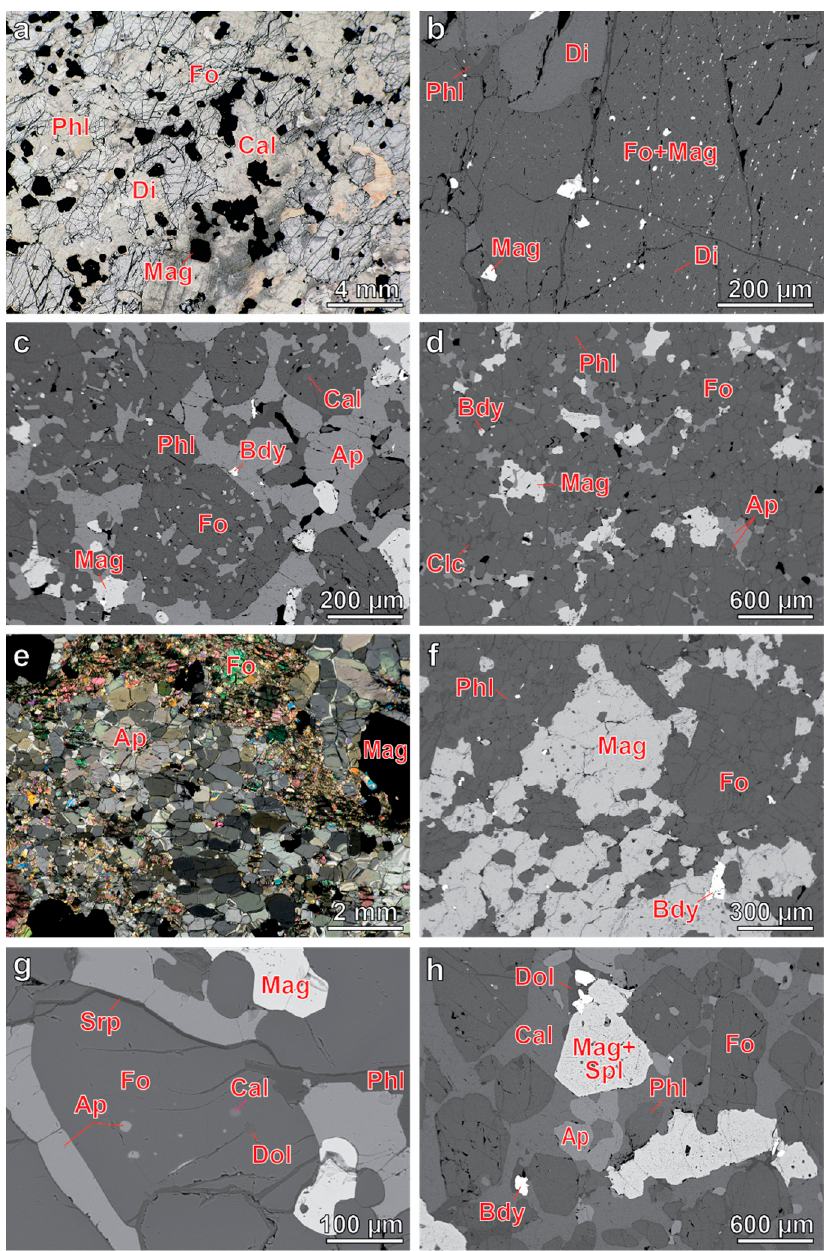
Figure 3. Morphology of forsterite and its relations with other minerals in rocks of the Kovdor alkaline-ultrabasic massif: ( a ) replacement of forsterite with diopside and phlogopite in peridotite 10p/76.01; ( b ) grain of forsterite with inclusions of diopside and magnetite in peridotite 912/231.6; ( c ) co-crystallization of forsterite (with inclusions of calcite) and hydroxylapatite in AF phoscorite 934/112.1; ( d ) interstitial segregations of magnetite and hydroxylapatite in AF phoscorite 976/33.1; ( e ) network of forsterite grains in MAF phoscorite 932/205.9; ( f ) typical MF phoscorite 983/64.6; ( g ) inclusions of hydroxylapatite, calcite and dolomite in forsterite grains of MAF phoscorite 938/30.6; ( h ) well shaped crystals of forsterite with inclusions of hydroxylapatite and calcite in CMF phoscorite 953/6.0. ( a , e ) images of polished thin section in transmitted light; ( b – d , f – h ) BSE images. Mineral abbreviations see in the Section 3.